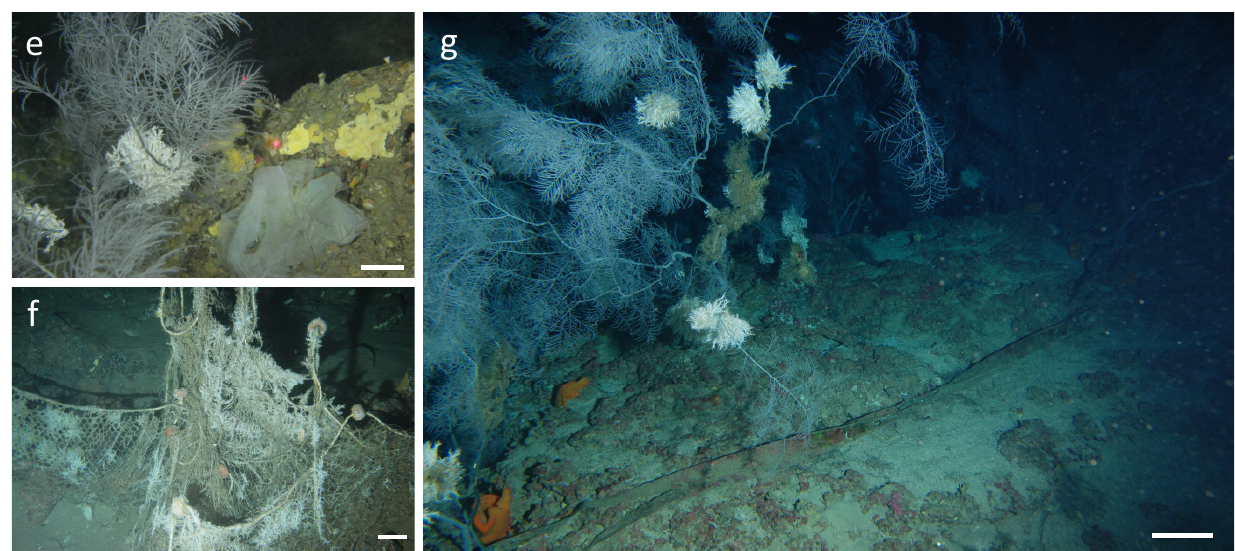
Figure 3. ROV images of anthropogenic impacts on the study sites. ( a ) Necrotic and epibiont-covered colonies of A. subpinnata ; ( b ) big trammel nets entangled on A. subpinnata colonies; ( c , d ) fishing-lines entangled on L. glaberrima colonies; ( e ) plastic bag next to a A. subpinnata colony; ( f ) epibiont-covered fishing net; ( g ) long, undefined object lying next to a tall A. subpinnata colony. Scale bar of approximately 10 cm.